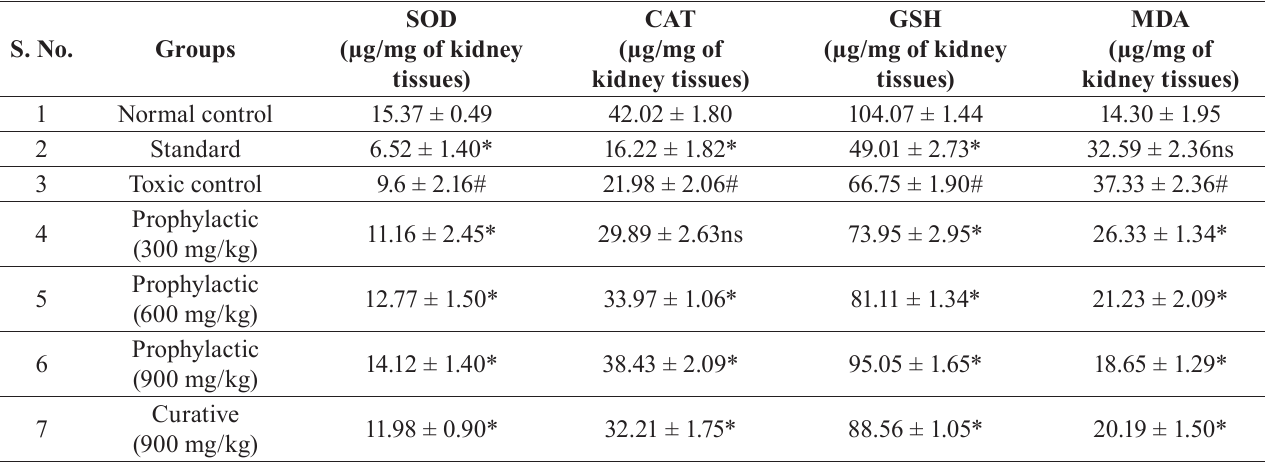
TABLE V - E valuation of kidney homogenate for in-vivo anti-oxidant activity after treatment of rats with Malva neglecta methanol extract for 21 days